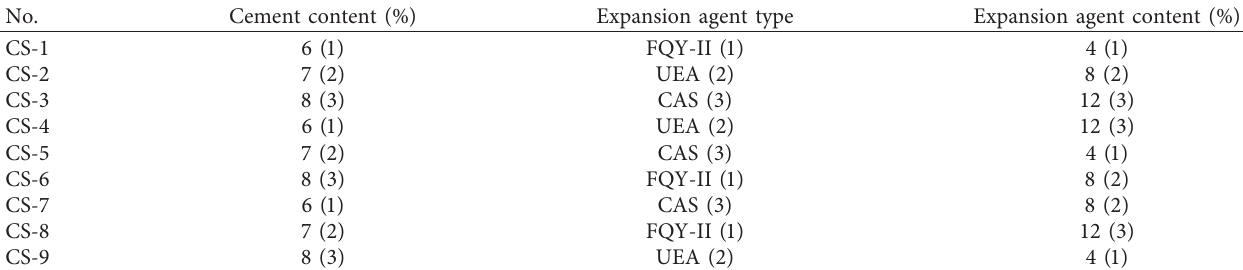
Table 6: Orthogonal design of